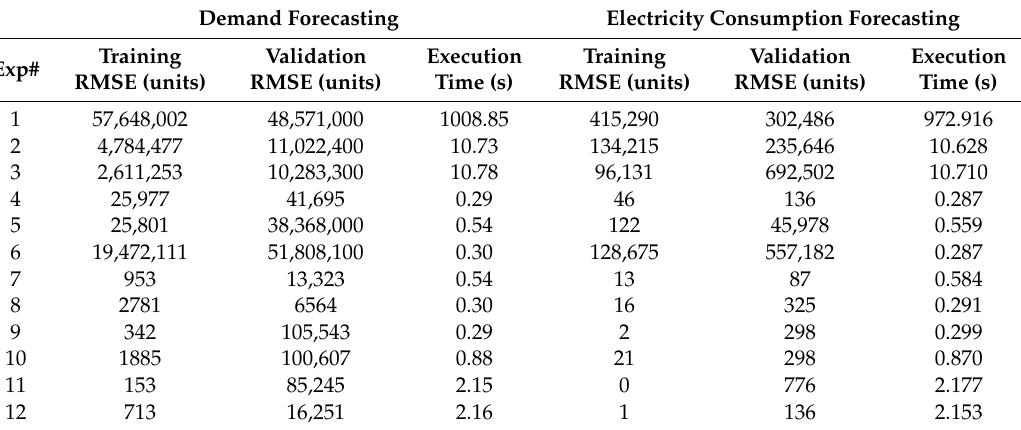
Table 3. Response measurement to the orthogonal